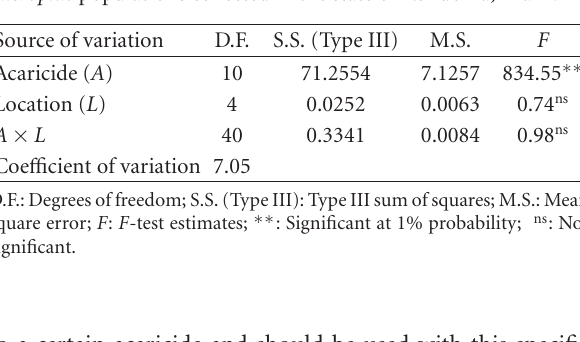
Table 2: Analysis of variance of the e ff ects of the location ( L ) and of the acaricides ( A ) on the susceptibility to acaricides in Rhipicephalus microplus populations collected in the state of Rondˆonia,